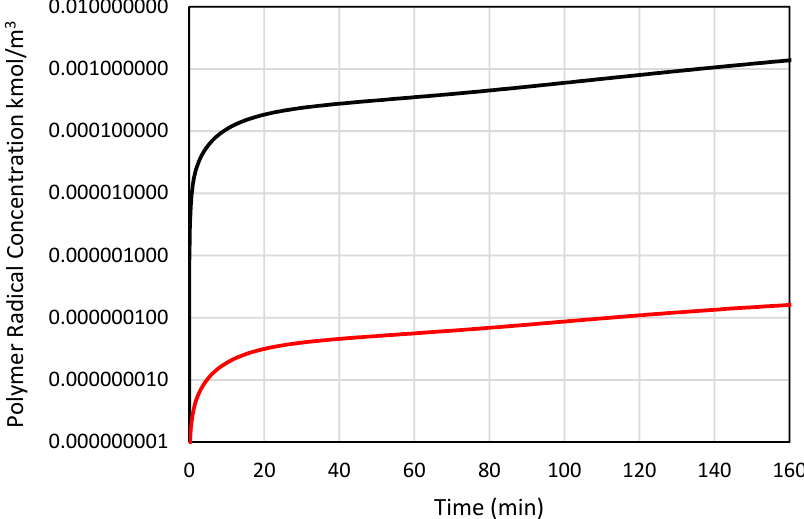
Figure 13. Calculated profiles of polymer radical concentration in the free radical polymerization of MMA using DTL2: overall polymer radicals (black solid line) and polymer radicals excluding dormant polymer P s DTL • (red solid line).